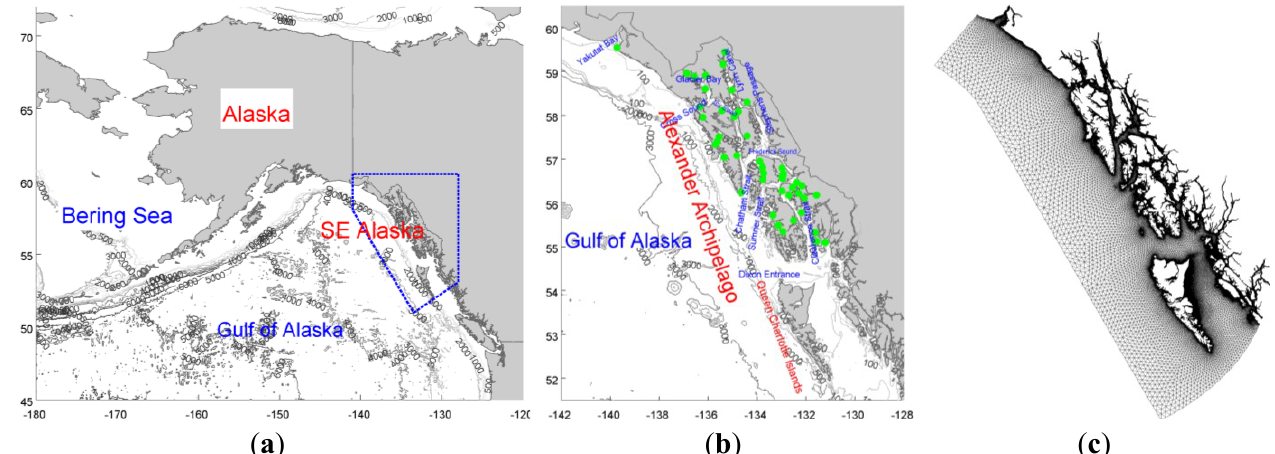
Figure 1. ( a ) Alaska shoreline and coast waters, and the southeast (SE) Alaska hydrodynamic model domain (blue polygon, approximately); ( b ) SE Alaska, bathymetry and tidal stations (green dots); ( c ) SE Alaska unstructured model